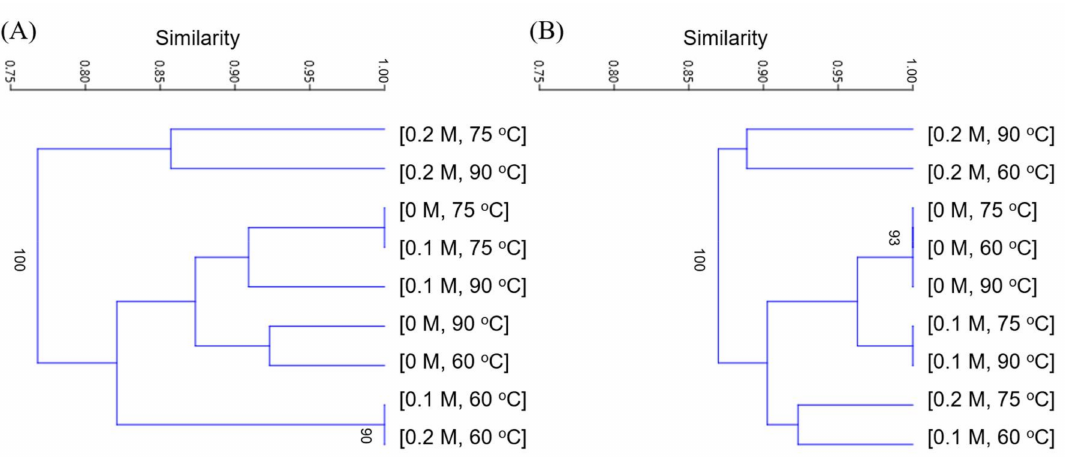
Figure 6. Cluster dendrograms constructed based on the archaeal ( A ) and bacterial ( B ) DGGE profiles. Each community profile is labeled with the corresponding pretreatment conditions, i.e., NaOH concentration (M) and temperature ( ◦ C). Bootstrap values higher than 80% (1000 replicates) are